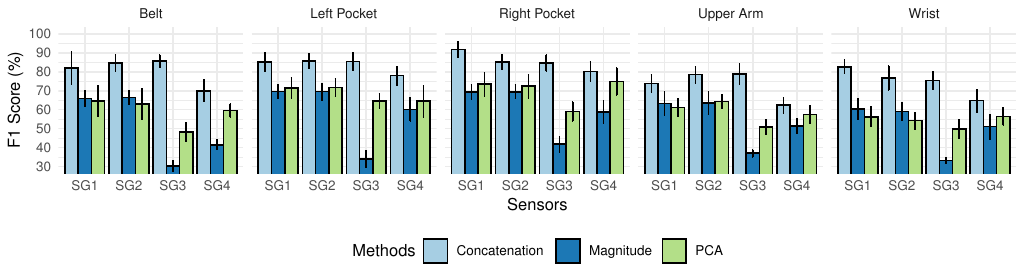
Figure 11. Comparison between data fusion techniques. The dataset used was